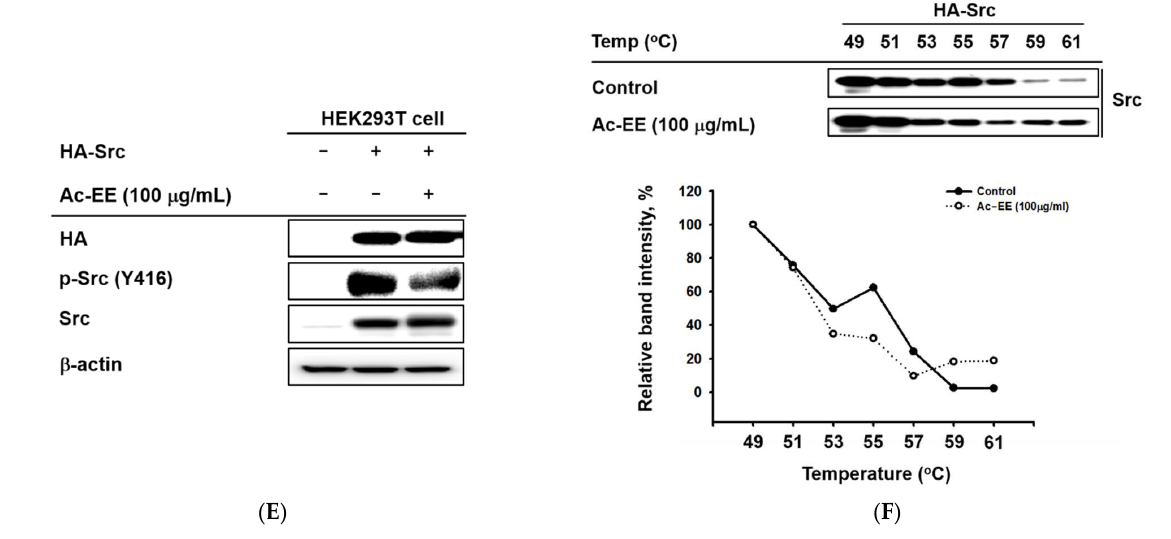
Figure 4. Strategies for finding the target of Ac-EE in anti-inflammatory responses. ( A ) The phosphorylation levels of NF-κB subunits and the protein expression levels of the total forms of the subunits were detected in whole cell lysates of RAW264.7 cells activated by 5 to 60 min of treatment with LPS after 30 min of pretreatment with 100 μg/mL Ac-EE. ( B ) Phosphorylation of the members of the NF-κB signaling pathway, p85, AKT, and IκBα, upon 5 to 60 min of LPS stimulation, was assessed by Western blot analysis. ( C ) The phosphorylation and total protein levels of protein kinase Src were confirmed after 2 to 5 min of LPS induction. ( D ) Western blotting analysis on the superior and post-caval lobes from LPS-treated mice indicates the phosphorylation and total protein expression levels of p50, p65, IκBα, and Src. ( E ) The phosphorylation level of Src in HA-Src-transfected HEK293T cells was detected by Western blot. ( F ) Cellular thermal shift assay was performed to confirm the direct interaction between Src and Ac-EE.